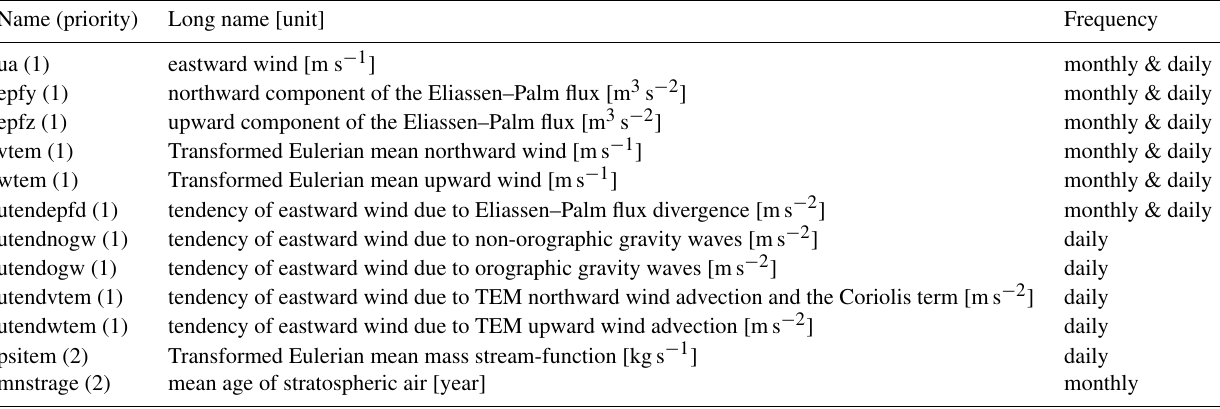
Table 2. Momentum (atmosphere). Zonal mean variables (2-D, grid: YZT) on the plev39 grid. The zonal mean zonal wind is requested, as it would otherwise be unavailable at this vertical resolution.